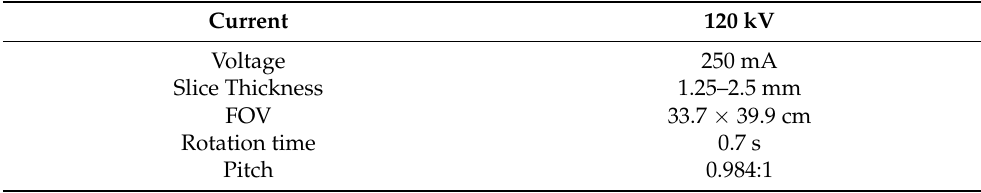
Table 2. Technical parameters of computed